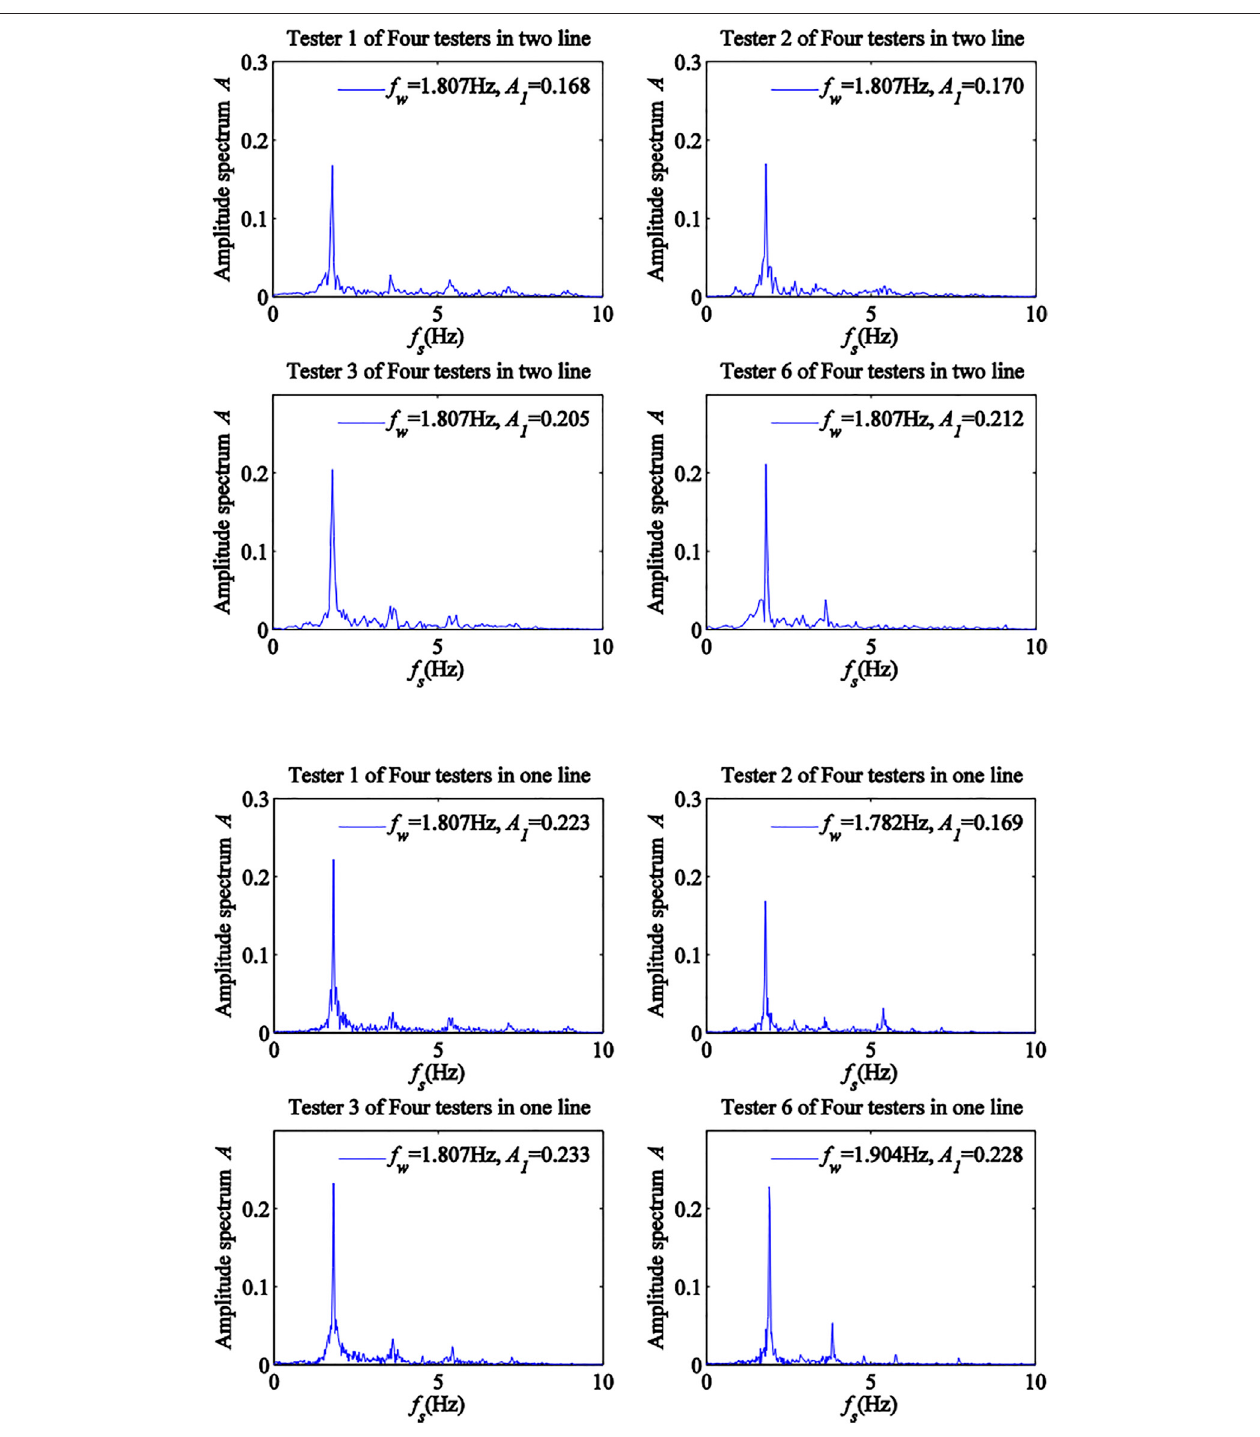
FIGURE 12 | Power spectra of pedestrian walking loads for four